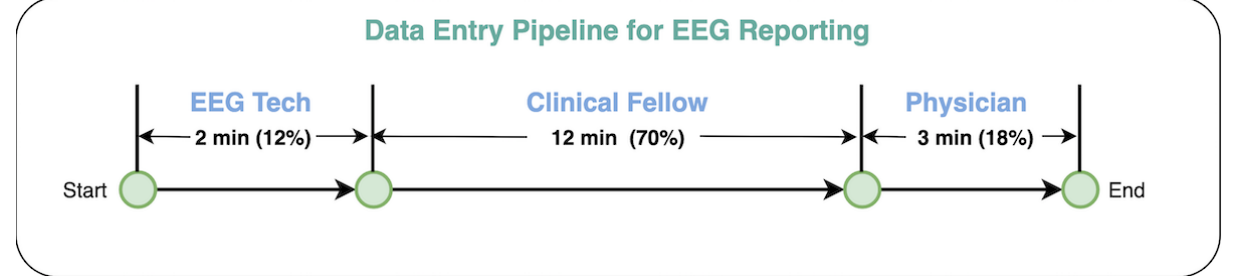
Figure 5. Collaborative data entry pipeline which reduces physician burden with patient documentation. EEG: electroencephalogram.